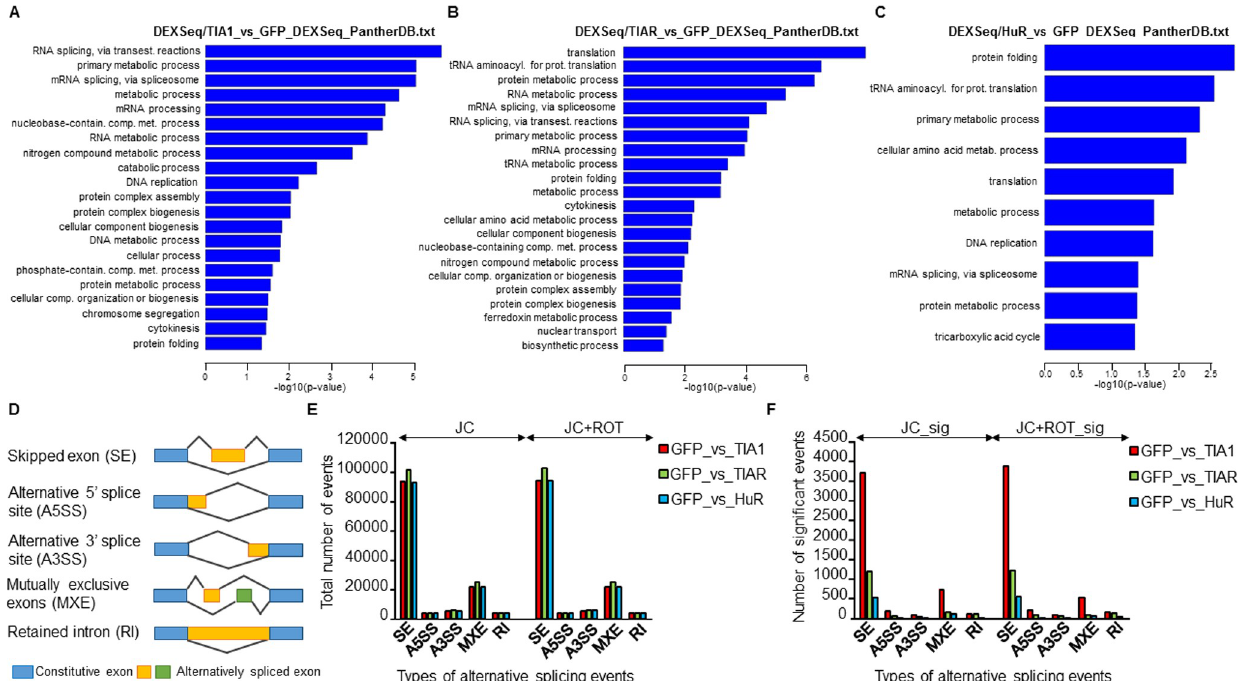
Fig 4. Gene Ontology (GO) analysis of differential splicing events (DSEs) in RBP-expressing FT293 cells. (A-C) Top categories of biological processes associated with DSEs using the GO PANTHER database ( P < 0.05). Histograms of the distributions of DSEs in the pairs TIA1 vs GFP (A), TIAR vs GFP (B) and HuR vs GFP (C) are shown. (D) Scheme and legends of differential alternative splicing events (ASEs) detected by multivariate analysis of transcript splicing (MATS) taken from Xing lab (http://rnaseq-mats.sourceforge.net). (E and F) Bar plots represent the number of each type of alternative splicing event detected using MATS. (E) JC: total number of events detected using junction counts only. JC+ROT: total number of events detected using both junction counts and reads on targets. (F) JC_sig and JC+ROT_sig represent number of significant events in the above categories, respectively.